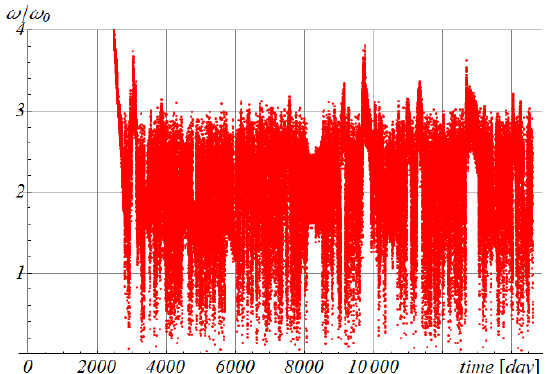
Figure 18. Angular velocity to orbital angular velocity ratio ω / ω 0 in case of chaotic final regime.